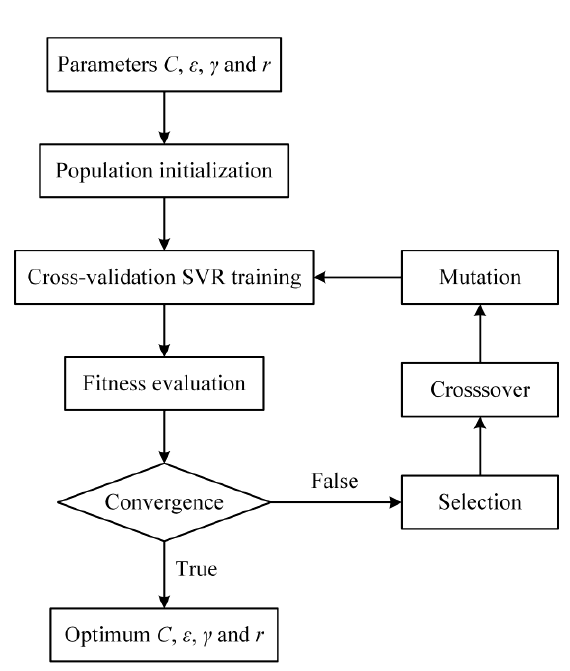
Figure 4. Over flowchart of genetic support vector regression (SVR) training to optimize parameters.